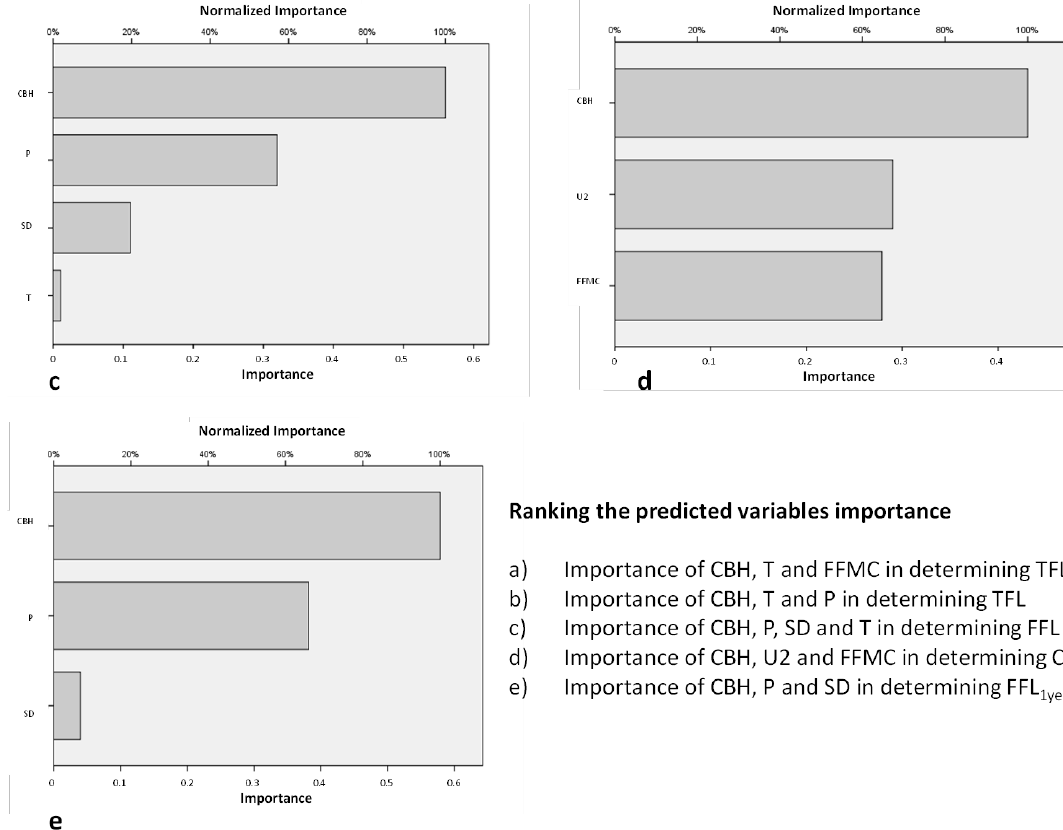
Figure 4. Ranking of the predicted variables’ importance based on an artificial neural network. The best mixed model for TFL was formed by three independent variables (CBH, T, and P) in a similar way to previous findings. In this sense, this statistical analysis had a standard error of estimation of 1.62. Therefore, it had a lower standard error of estimation than the previous multiexponential models (Table 6). The covariance of the residuals in the mixed model was 1.62 (±0.38). Table 6. Parameter estimations obtained by the mixed linear model.